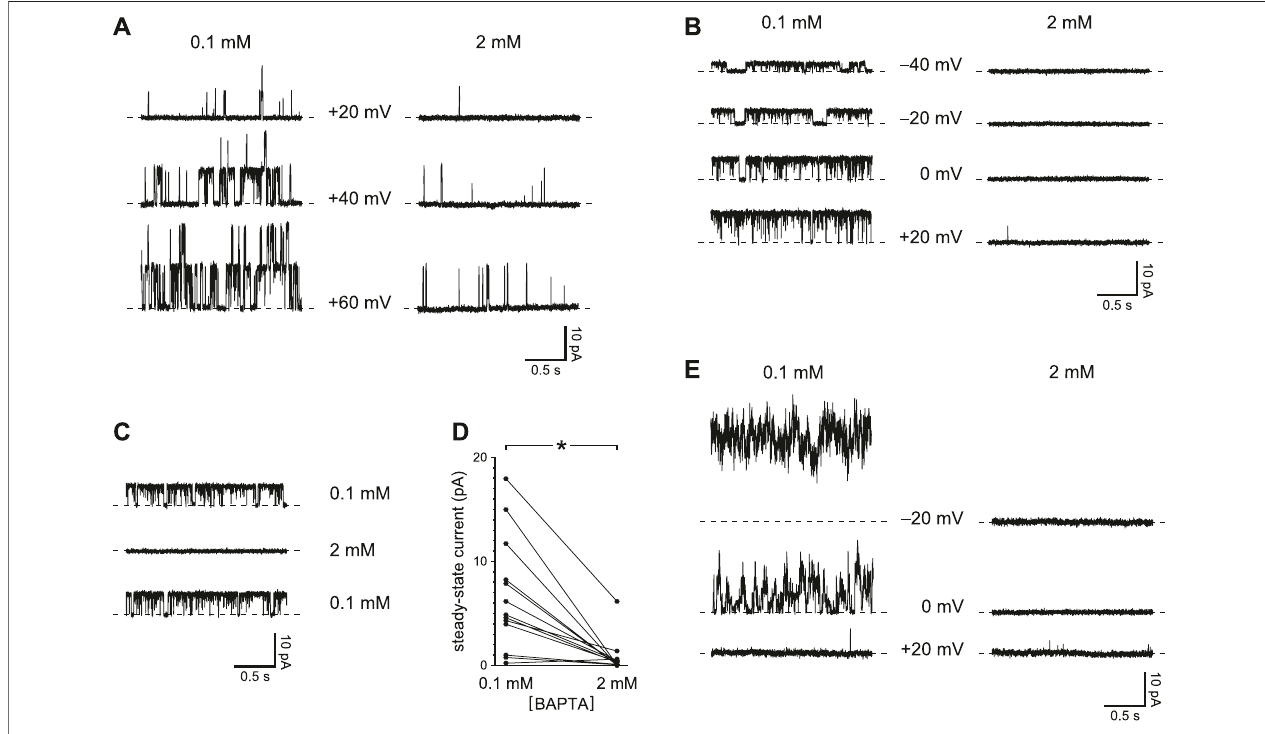
FIGURE2| Steady-stateactivityofPC2channelsisgreaterwithreducedCa 2+ buffering(0.1 mMBAPTAcomparedto2 mMBAPTA). (A) Steady-stateactivitywas measuredinonecilium atthevoltages shown in0.1 mM BAPTA (left)and2 mM BAPTA (right). (B) Inacilium withjustonePC2channel,thechannelalsoshowedhigher steady-state activity with the lower concentration of BAPTA. (C) The effect of reduced Ca 2+ buffering is reversible. A cilium with a single PC2 channel showed higher steady-state activity in 0.1 mM BAPTA before and after exposure to 2 mM BAPTA. Voltage was maintained at 0 mV. (D) Paired mean steady-state currents for 13 cilia,eachtestedinboth0.1and2 mMBAPTA.Voltageswerechosenthatgavethegreatestdifferenceinmeancurrentbetween0.1and2 mMBAPTAandrangedfrom − 20 to +80 mV * p < 0.001. (E) Steady-state currents in the one cilium in which activity increased with hyperpolarization in the presence of 0.1 mM BAPTA.